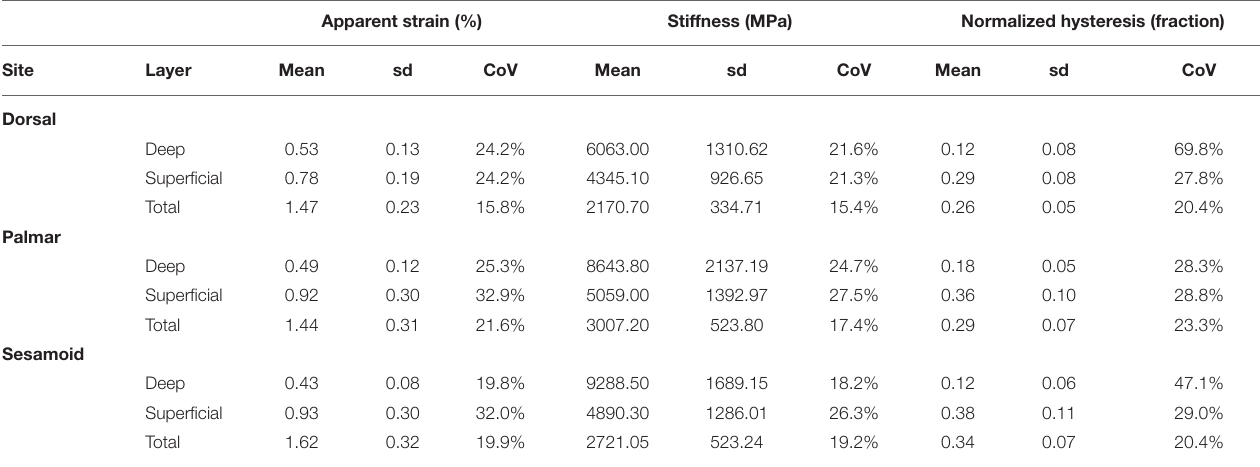
TABLE 2 | Descriptive statistics of first cycle apparent strain (%), stiffness (MPa), and normalized hysteresis (fraction) by the site (dorsal MCIII, palmar MCIII, and proximal sesamoid) and layer (superficial 2mm, deeper 2mm, and total ∼ 10mm thick specimen) from cartilage-bone samples taken from the metacarpophalangeal joints of Thoroughbred racehorses at post-mortem ( n = 10). Apparent strain (%) Stiffness (MPa) Normalized hysteresis (fraction)